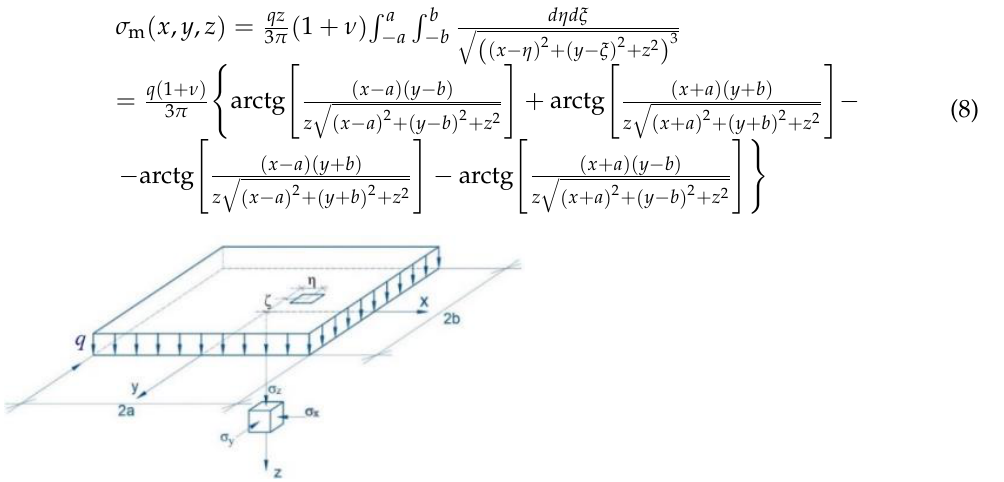
Figure 3. Stress in an elastic half-space caused by a uniformly distributed load on the surface. While considering the obtained expressions (7) and (8) on the vertical axis z ( x =